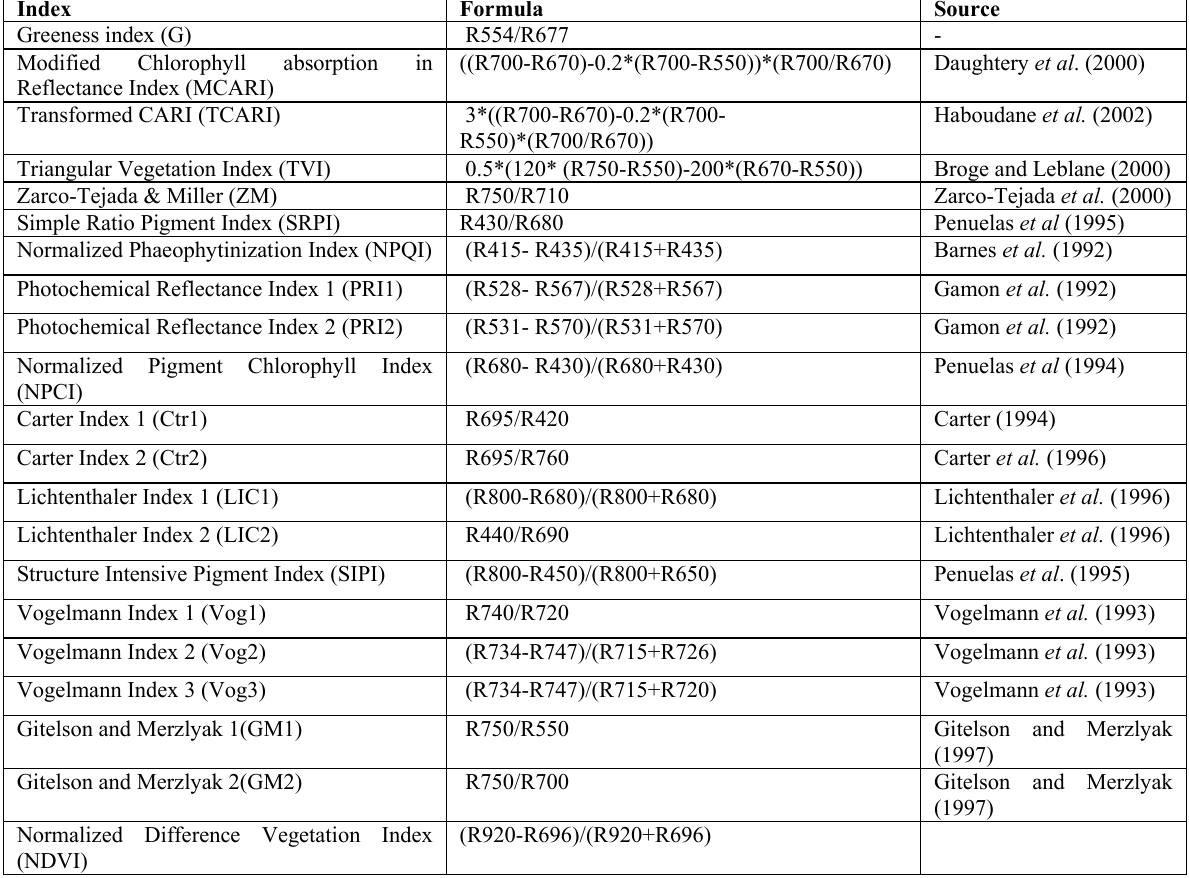
Table 1. Formulas used for computation of various hyperspectral vegetation